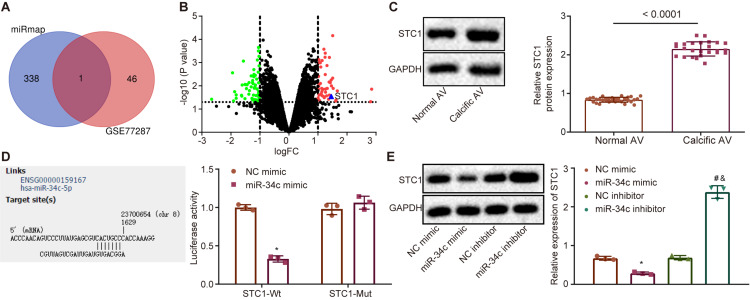
The expression of STC1 is downregulated by miR-34c. (A) intersection between target genes predicted by the miRmap database (score > 95) and genes highly expressed in calcified AV in GSE77287. (B) Volcano plot of differentially expressed genes in microarray datasets GSE77287 of calcified AV. The downregulated genes were presented in green dots and upregulated genes were presented in red dots. The triangle represented the gene STC1. (C) Protein expression of STC1 in clinical AV samples determined by western blot analysis. Data are presented as mean ± standard. The comparison between negative control (n = 32) and CAVD (n = 25) was checked by unpaired Student’s t test. (D) Dual luciferase reporter gene assay to verify the correlation between miR-34c and STC1. (E) Protein expression of STC1 measured by western blot analysis after the overexpression or silencing of miR-34c in VICs. Data were presented as mean ± standard deviation from at least three independent experiments. Comparison between two groups was checked by unpaired Student’s t test. ∗p < 0.05 vs. negative control clinical samples. #p < 0.05 vs. VICs transfected with NC mimic. &p < 0.05 vs. VICs transfected with NC inhibitor.